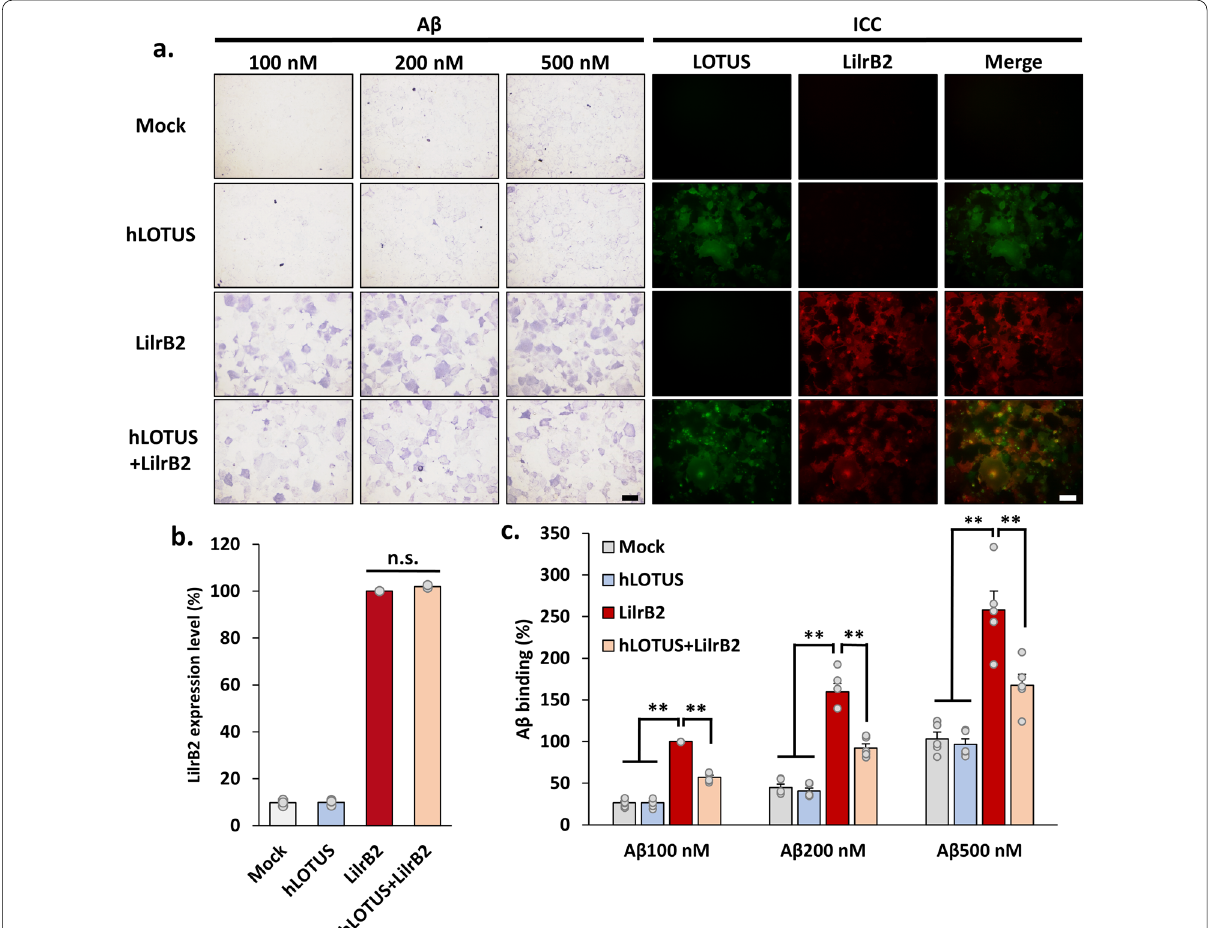
Fig. 5 Human LOTUS inhibits Aβ binding to LilrB2. a Representative images of the binding assay in Cos7 cells overexpressing human LOTUS or LilrB2. The cells were treated with biotin-conjugated-human Aβ and immunostained using LOTUS or PirB antibody without Aβ. Scale bars, 100 µm. b Quantification of cell surface expression level of LilrB2 in Cos7 cells overexpressing human LOTUS and/or LilrB2. Each expression level of LilrB2 was normalized to the expression level in Cos7 cells overexpressing LilrB2 alone, and the data are presented as mean culture preparations (n 4, one-way ANOVA post hoc Tukey test n.s., not significant). c Quantification of Aβ binding in Cos7 cells overexpressing = LOTUS or LilrB2. Aβ binding levels in each group were normalized to the binding level of Aβ (100 nM) in Cos7 cells overexpressing PirB alone, and the data are presented as mean SEM (n 5, One-way ANOVA post hoc Tukey test * p < 0.05, ** p < ± =